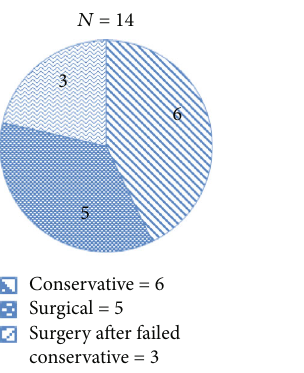
Figure 5: Pie chart depicting the mode of management for all